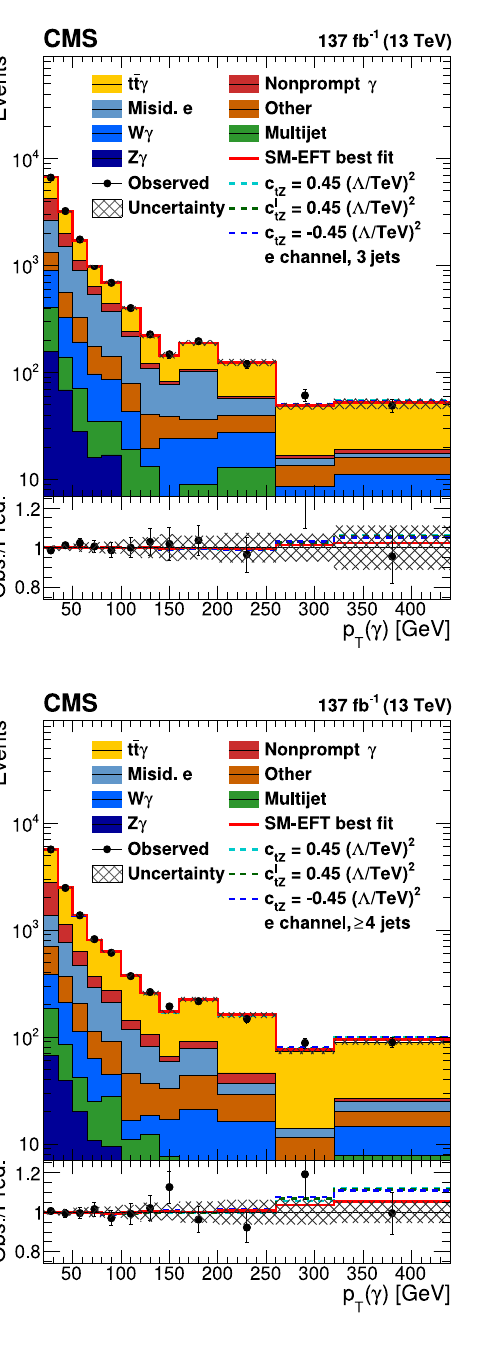
= 0 . 45 (light blue), c I = 0 . 45 (green), and tZ tZ